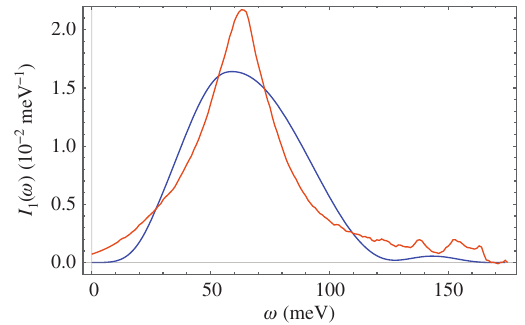
Figure 7: Comparison of the one-phonon bands of the NV −1 [13] and ST1 optical